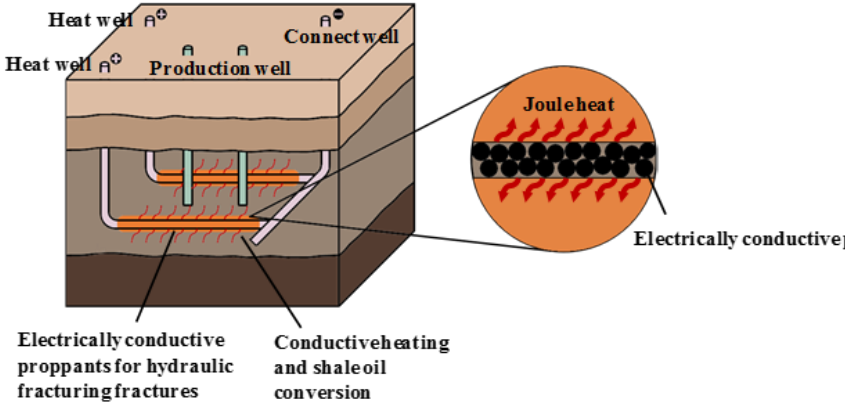
Figure 1. Schematic diagram of electric heating in-situ modification technology and electrically conductive proppants.